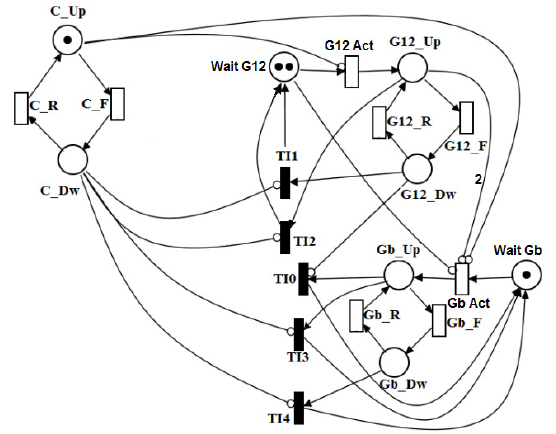
Figure 15. SPN model for the utility power and generator system (UP +